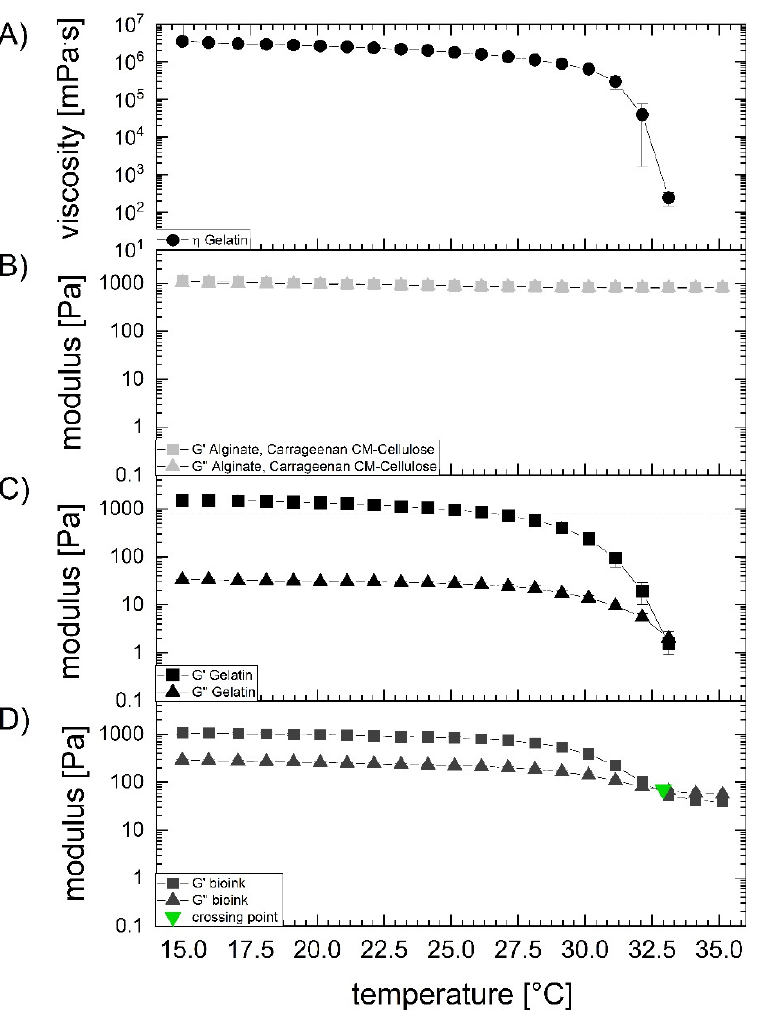
Figure 3. Temperature sweeps of the carrier material and its components. ( A ) Rheological behavior of the gelatin component in rotation mode at 0.1 s − 1 . ( B ) Temperature dependency of the κ -carrageenan, CMC, and alginate component in oscillation mode (1% strain, 10 rad · s − 1 ). ( C ) gelatin component in oscillation mode (1% strain, 10 rad · s − 1 ). ( D ) Temperature dependency of the mixed carrier material in oscillation mode (1% strain, 10 rad · s − 1 ) showing the crossing point. Data are means ± SD ( n = 3). The sedimentation time of single cells was evaluated as a function of shear rates and temperatures in different fluids (Table 3). For the final carrier material mixture at 37 ◦ C, an increase in shear reduced the sedimentation time. The slowest sedimentation was observed for carrier material with zero shear (1,714,440.5 min) whereas the fastest sedimentation was observed for carrier material with infinity shear (0.6 min). However, even at high shear rates of 1000 s − 1 , the sedimentation time was at 3061.0 min, suggesting that sedimentation is unlikely to occur during processing. The sedimentation time for a gelatin solution at 28 ◦ C (Figure 3) was 6,900,247.9 min for single cells at a very low shear rate of 0.1 s − 1 . In contrast, cells suspended in pure water at 37 ◦ C sedimented after 6.1 min, indicating that insufficient viscosity leads to poor homogeneity in the resulting